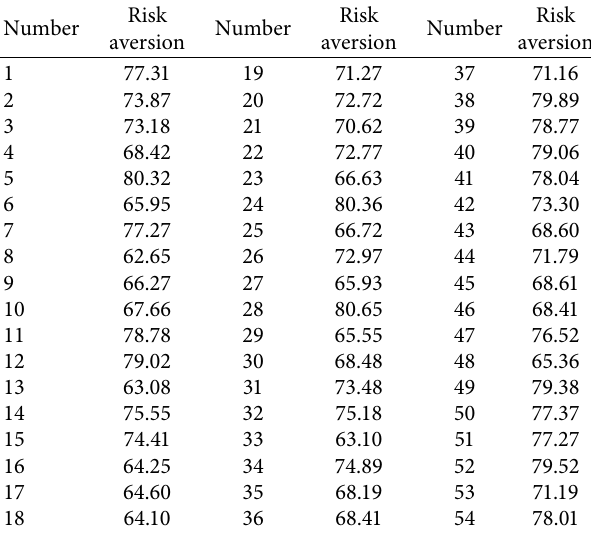
Table 2: Risk aversion effect of the financial risk aversion model based on sensor and edge